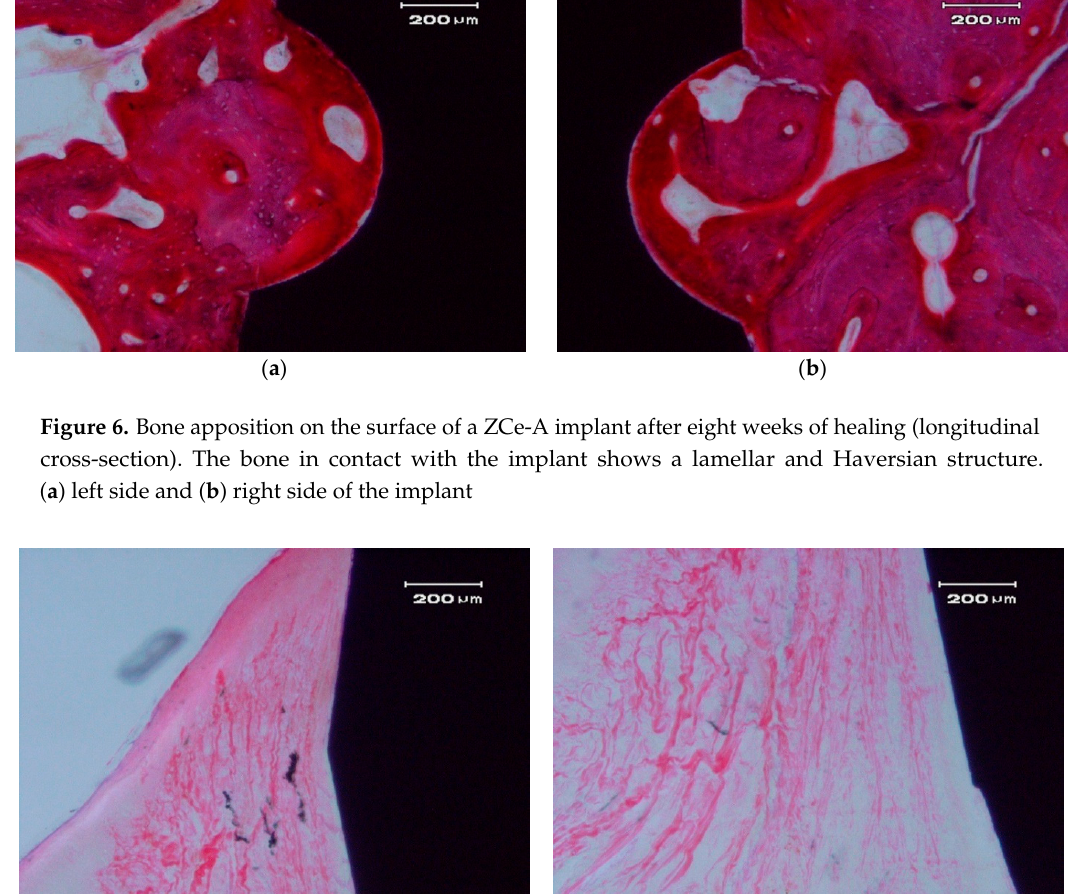
Figure 7. Contact between a ZCe-A nanocomposite implant and soft gingival peri-implant tissue after eight weeks of healing (longitudinal cross-section). ( a ) and ( b ) show two different interfaces.